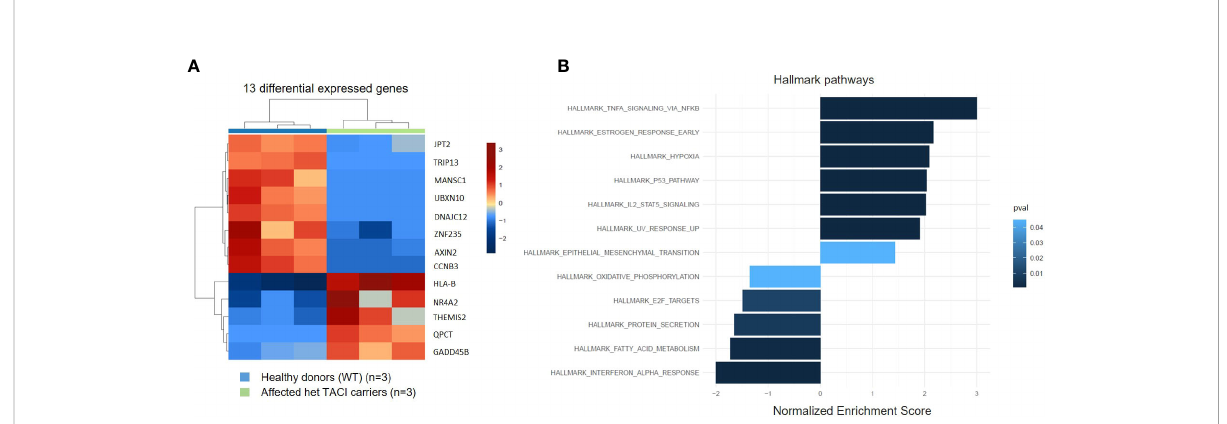
FIGURE 3 Expression pattern of differentially expressed genes from unstimulated naïve B cells from TACI mutation carriers and healthy donors. (A) Heatmap of DEG on RNA level for unstimulated naïve B cells from TACI mutation carriers and WT (log2 fold change >0.5) Red: upregulated genes; blue: downregulated genes. (B) Statistically over-represented Hallmark pathways associated with increased (right bars) or decreased (left bars) DEG depicted by the